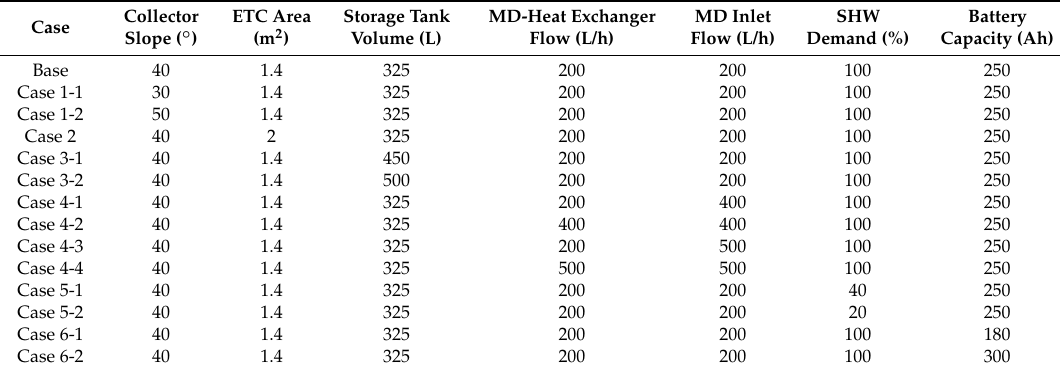
Table 7. Parametric simulations of some free-design variables in the